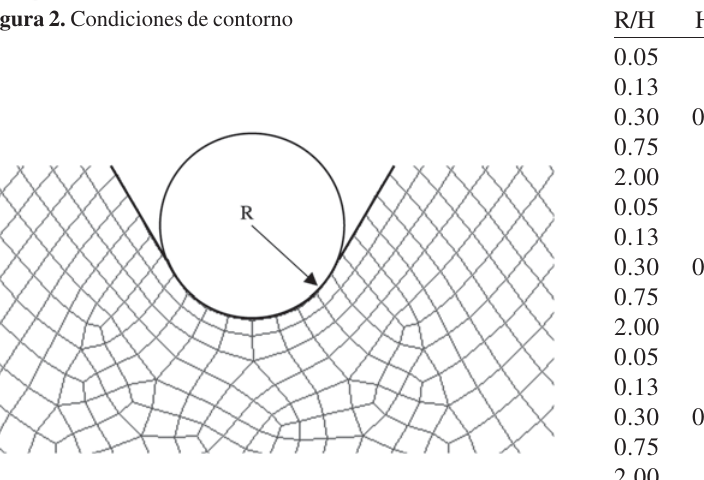
Figura 3. Malla de elementos finitos.